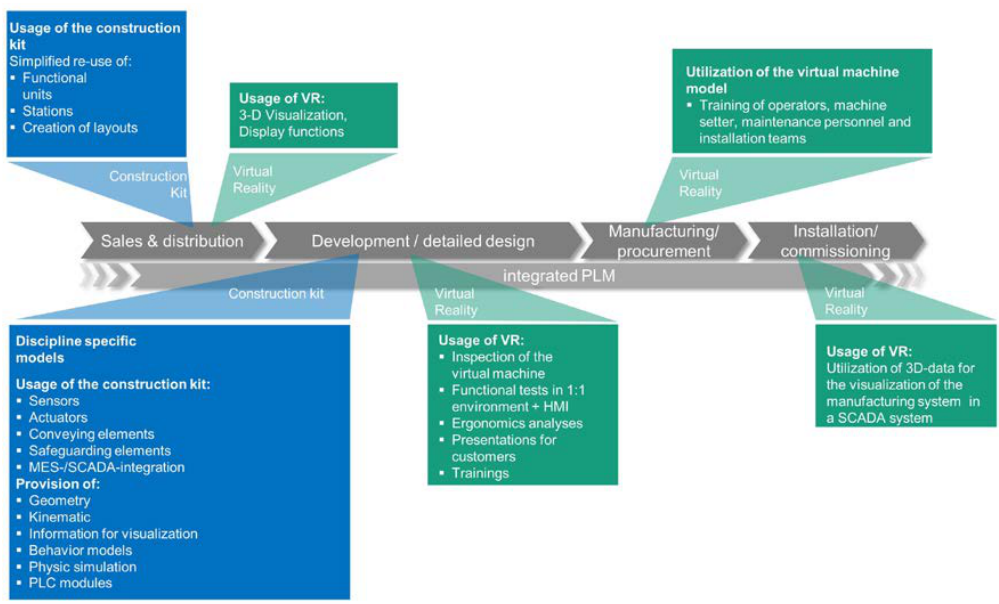
Figure 2. Virtual technologies and usage of the construction kit within the product development process of an assembly system.